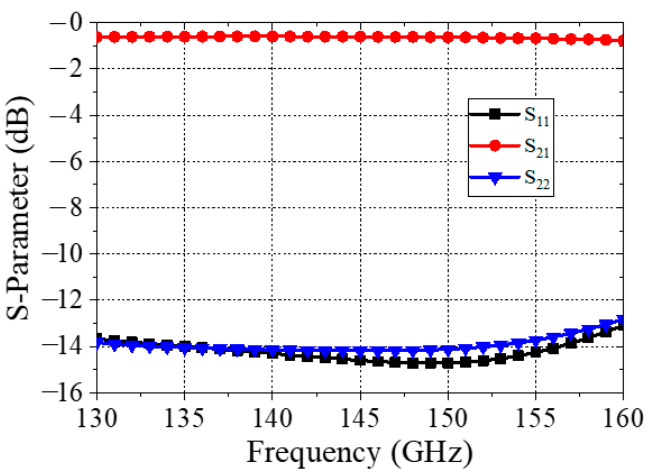
Figure 13. S-parameters of the optimized Klopfenstein taper-based coplanar waveguide to mi- crostrip transition.